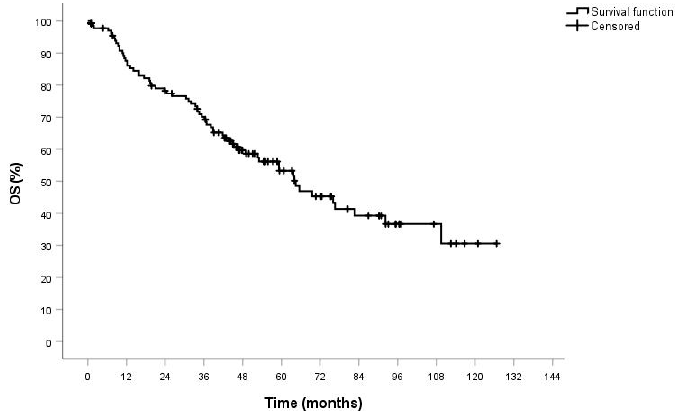
Figure 2. Overall survival of high-risk population after robotic surgery for lung cancer. According to the pathological stage, OS was 91% for early stages and 65% for advanced stages at 12 months, reaching 57% for early stages and 40% for advanced stages at 60 months, with a statistically significant difference ( p = 0.011) (Figure 3). Twenty-one patients were lost at follow up.